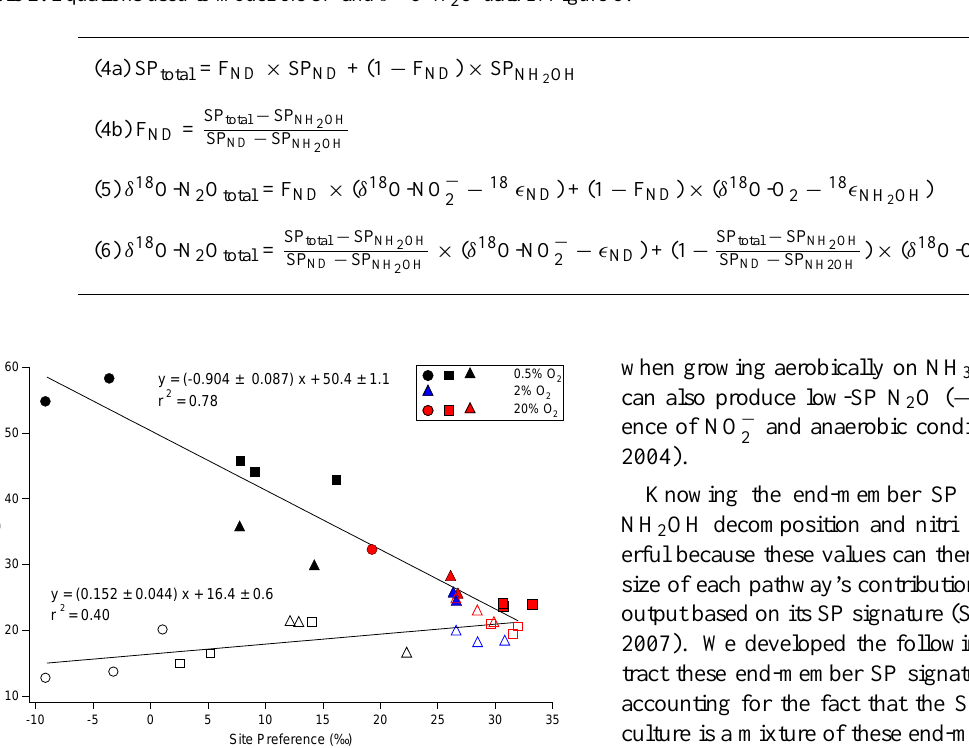
Table 2. Equations used to model the SP and δ 18 O-N 2 O data in Figure 5.